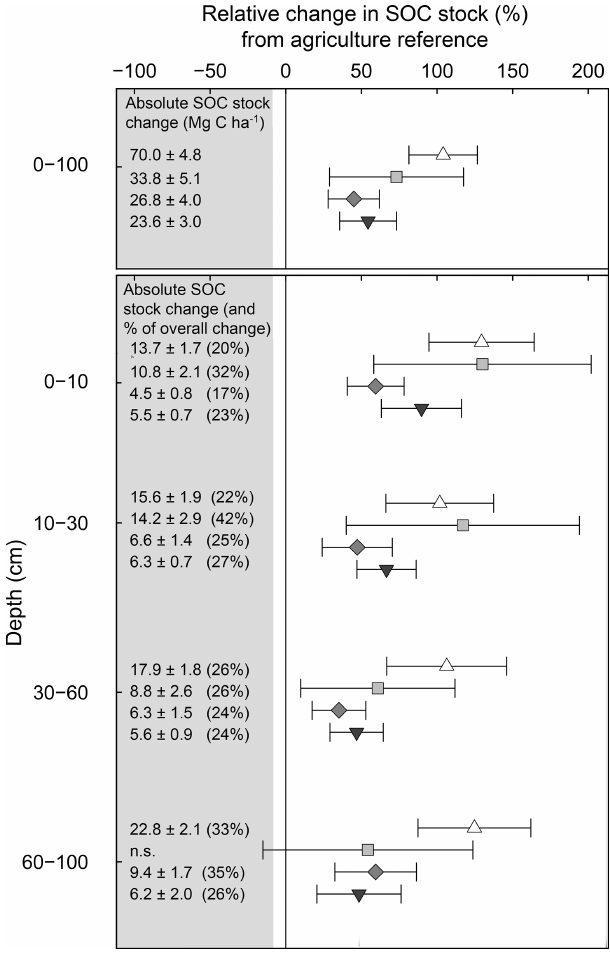
Figure 3. Relative change in SOC stock in the 1m soil profile from agriculture to agroforestry systems: home garden ( ; n=27), coffee ( ; n=9), coconut ( ; n=28) and mango ( ; n=28). Error bars indicate the 95% confidence intervals based on the Student’s T distribution. The numbers in the grey shaded area show the absolute changes in SOC stocks (Mg C ha -1 ) (n.s. = not significant). The numbers in brackets indicate the corresponding carbon change in percent of the overall change in the soil profile.